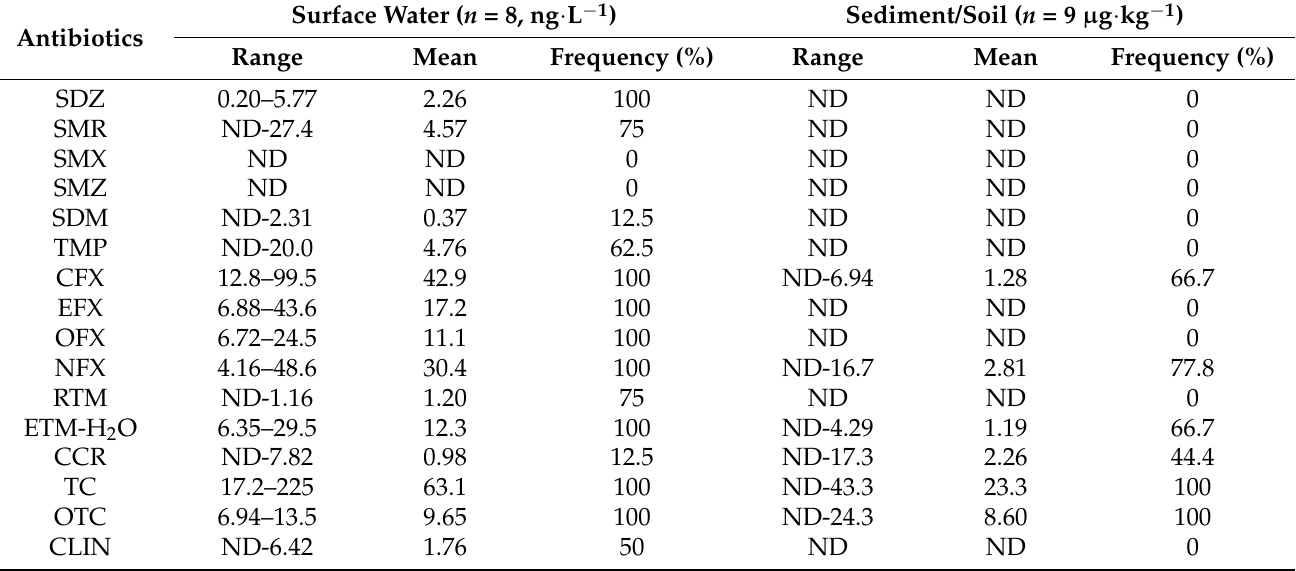
Table 3. Concentrations and frequency of antibiotics in